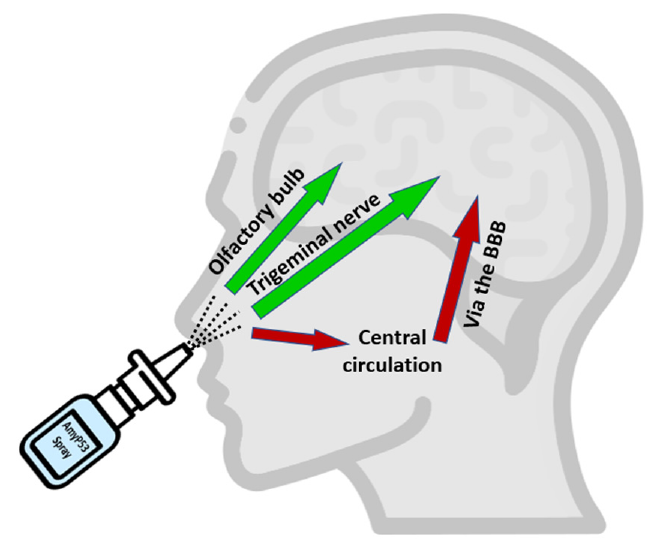
Figure 8. Pathways of AmyP53 intranasal transport. Following intranasal administration, AmyP53 can reach the brain by direct and indirect pathways. The direct pathway may occur via the trigeminal nerve or the olfactory bulbs. The indirect pathway may involve successively blood circulation and the blood–brain barrier (BBB). Table 4. Therapeutic peptides delivered to the brain via the intranasal